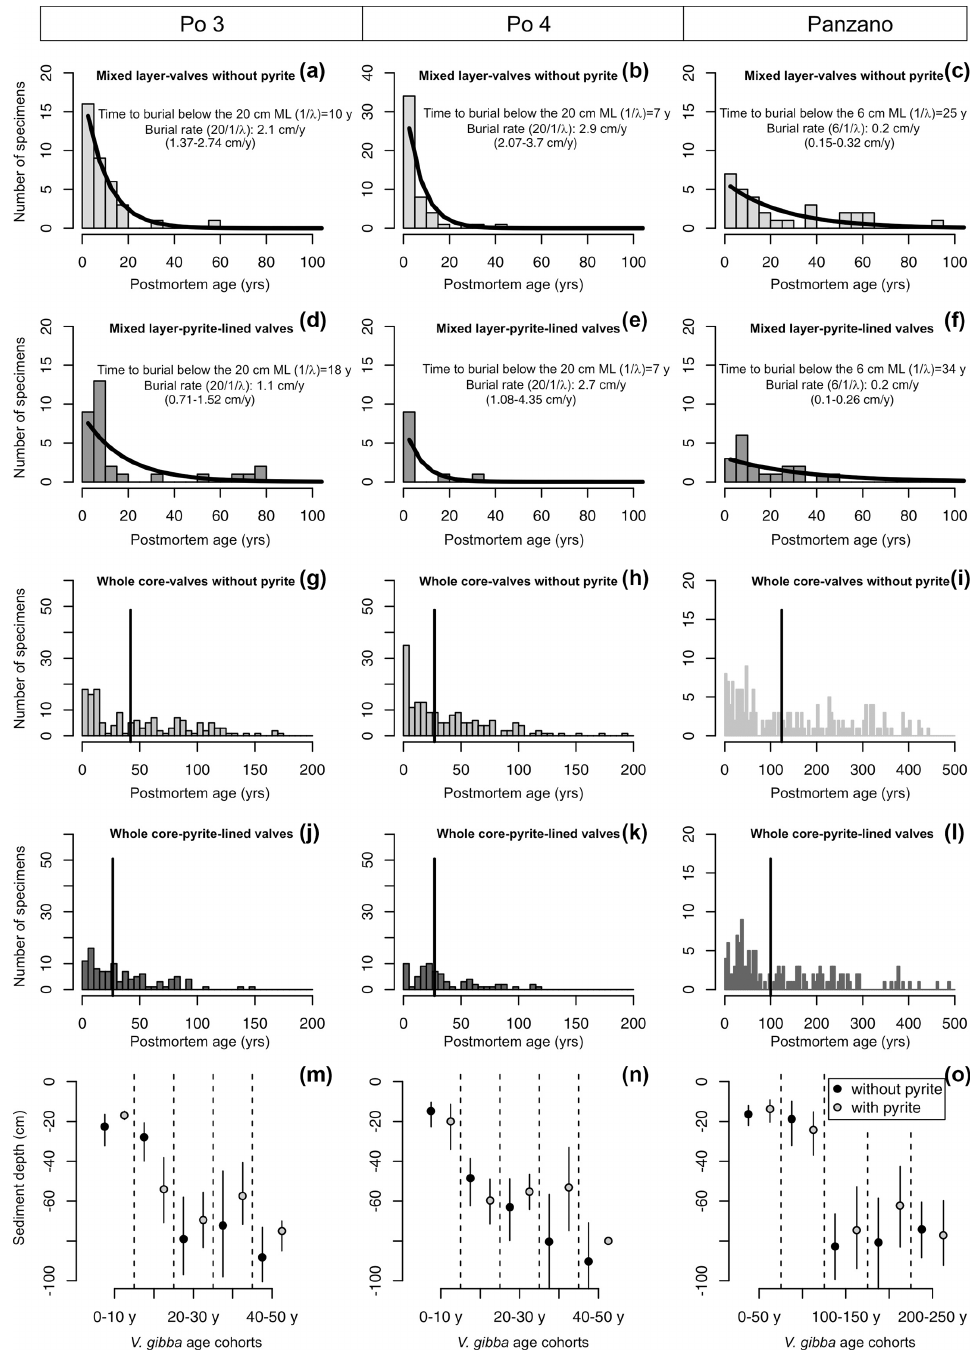
Figure 10. (a–l) Mixed-layer (a–f) and whole-core distributions (g–l) of postmortem ages of V. gibba from Po 3, Po 4, and Panzano with valves with and without pyrite showing that first, even the youngest valves less than 5–10 years old have pyritic linings. Second, the mixed- layer distributions of valves with and without pyrite show similar right-skewed shapes well-fitted by a simple exponential model (black lines) that indicates that both types of valves are buried below the mixed layer at a similar rate (burial rate corresponds to inverse of the mean age of the distribution, with 95% confidence intervals in parentheses). The burial rate estimated on this basis is congruent with downcore changes both in median shells ages and in 210 Pb-based estimates of sedimentation rate at Po and Panzano, indicating that the steepness of mixed-layer age distributions primarily corresponds to burial rates. At the scale of whole cores (g–l) , pyrite-lined valves exhibit a mode at ∼ 25 years at Po 4 and a mode at ∼ 50 years at Panzano. (m–o) Mean sediment depths of valves with (gray) and without pyrite (black) of the same age are similar. Both age and depth distributions indicate a scenario in which pyrite formation is not associated with deeper burial and occurs in reduced microenvironments in near-surface sediment